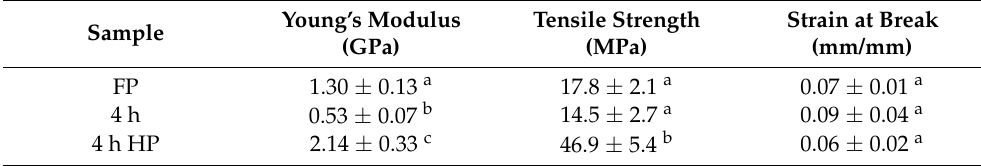
Different letters in the same group indicate a statistically significant difference ( p <